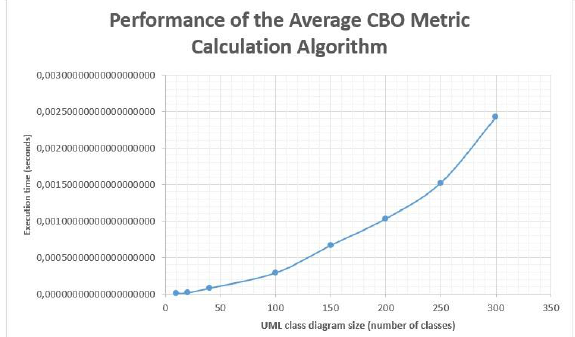
Fig. 4. Performance of the Average CBO Metric Calculation